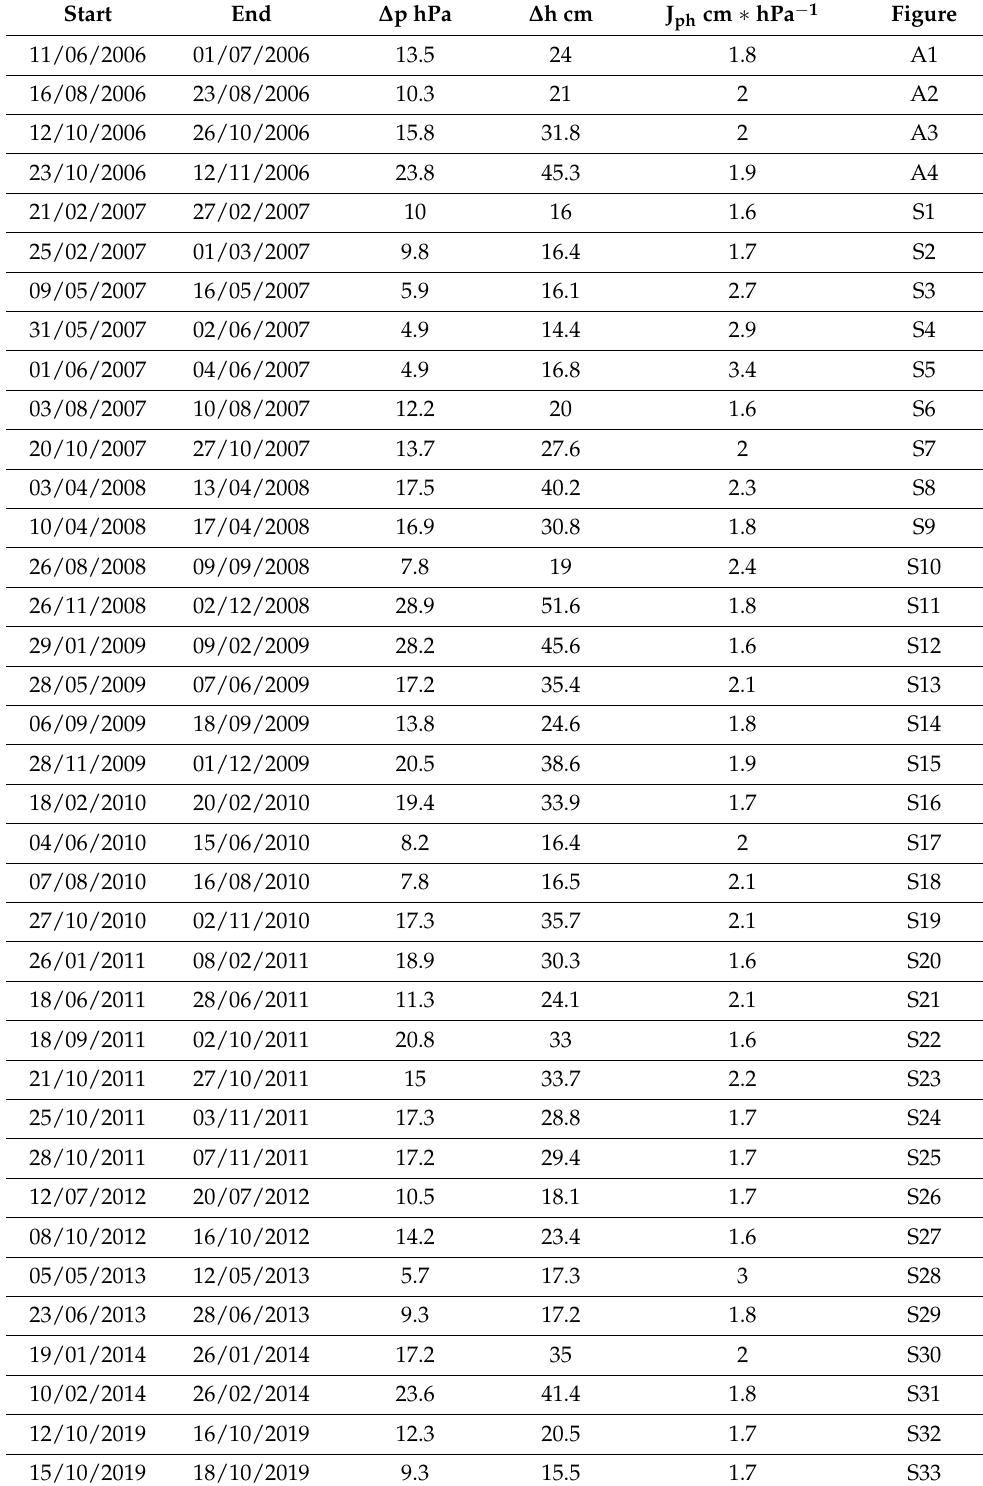
Table A1. Estimated values for representative events occurred from 2006 to 2021 in the port of La